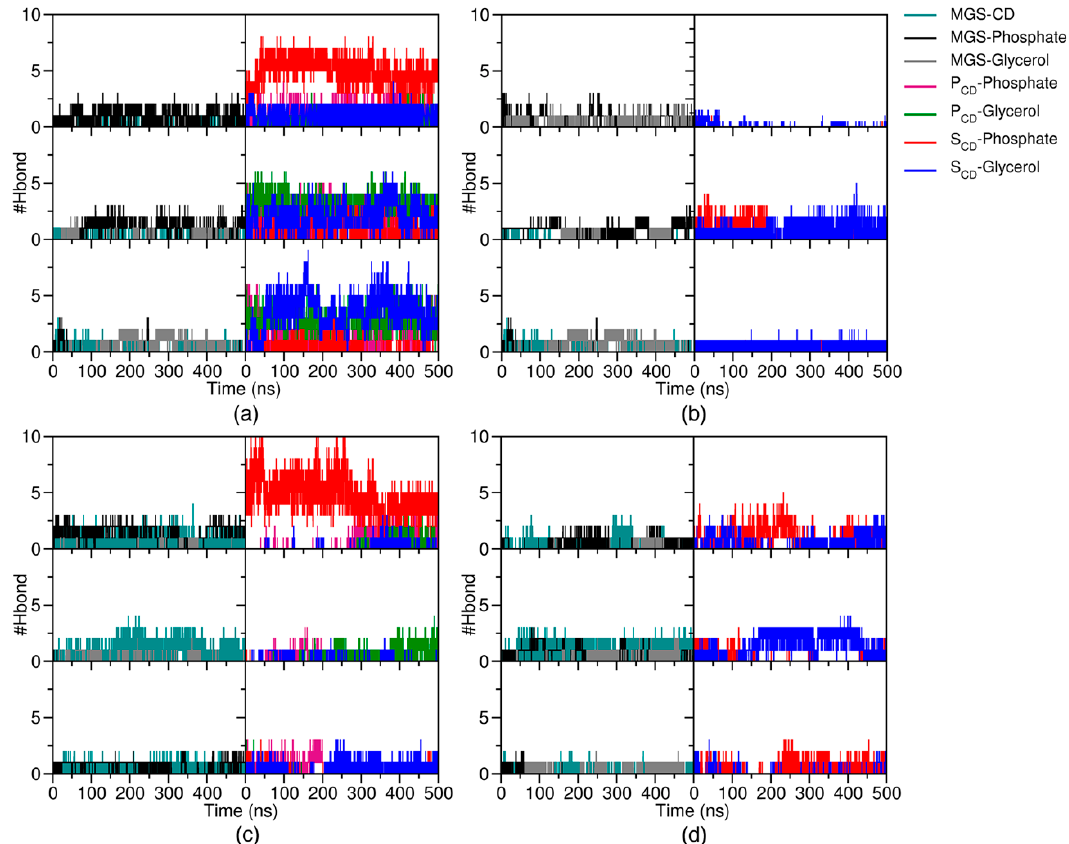
Figure 6. The number of H-bonds in triplicate MD simulations for each inclusion complex of ( a ) A-MGS / β CD, ( b ) A-MGS / DM β CD, ( c ) C-MGS / β CD, and ( d ) C-MGS / DM β